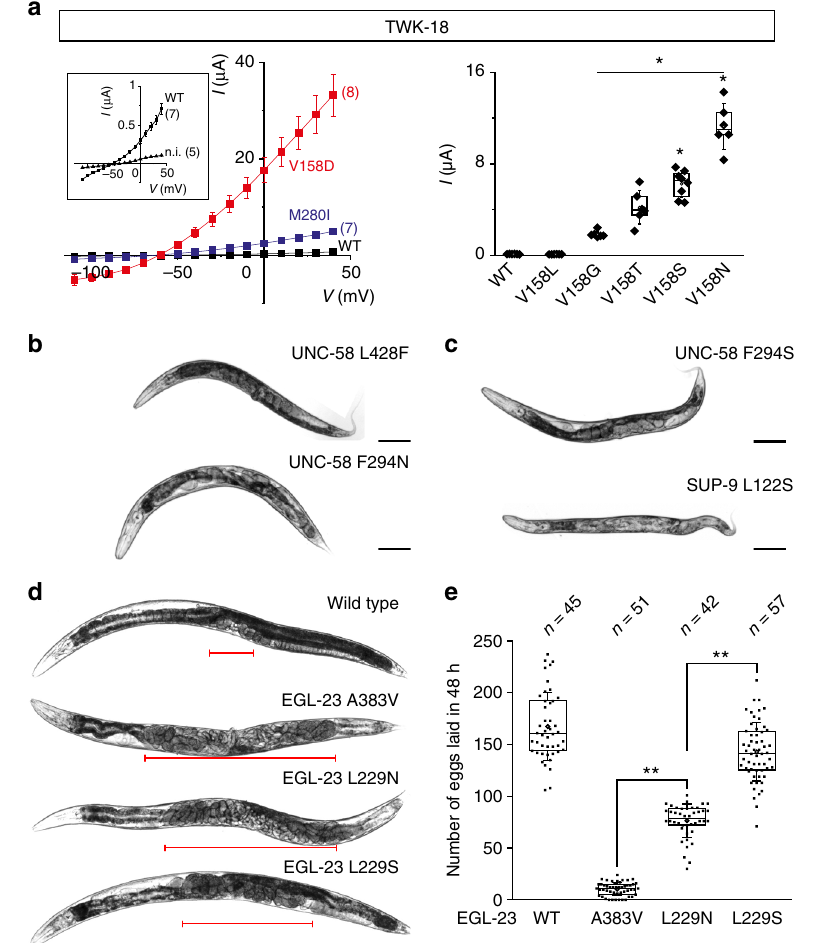
Fig. 6 Tuning K2P channel activity in vivo using CRISPR/ Cas9 gene editing in C . elegans . a (left panel) Current – voltage relationships obtained at pH 7.4 in X . laevis oocytes for TWK-18 wild-type (black squares), TWK-18 M260I (blue squares), and TWK-18 V158D mutant channels (red squares). Inset, current – voltage relationship for wild-type channel and non-injected oocytes at a reduced scale. a (right panel) Gradual increase of TWK-18 whole-cell current in a series of TM2.6 mutants. Currents at 0 mV were recorded 24 h after injection of cRNA at 30 ng/oocyte. Each data point represents one oocyte. b Representative micrographs of 1-day old adult UNC-58 L428F, UNC-58 F294N, UNC-58 F294S, c SUP-9 L122S, and d wild type, EGL-23 A383V, EGL-23 L229N, and EGL-23 L229S worms. Red brackets mark the central section of each animal where embryos accumulate. Scale bars, 10 µ m. e Comparison of egg-laying rates of wild-type worms and egl-23 gain-of-function alleles. Each data point represents the number of embryos laid by a single animal over a 48-h period. n , number of animals tested. Center lines, medians; open circles, means; box limits, 25th and 75th percentiles; whiskers, standard deviation. Kruskal – Wallis, Dunn ’ s multiple comparison test, * p